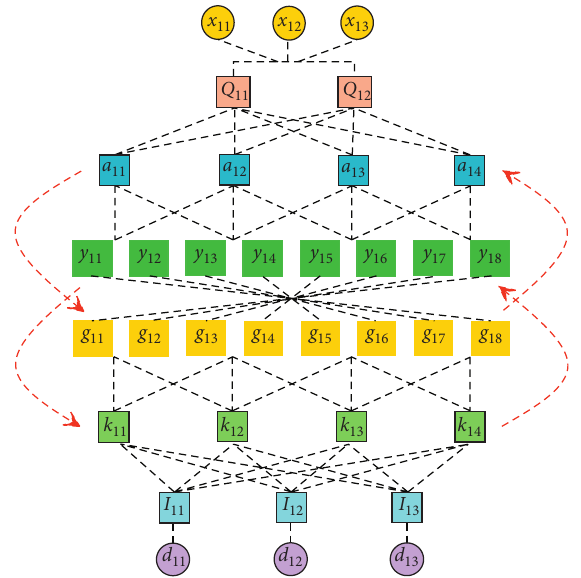
Figure 3: Method and principle for optimal allocation of risk control